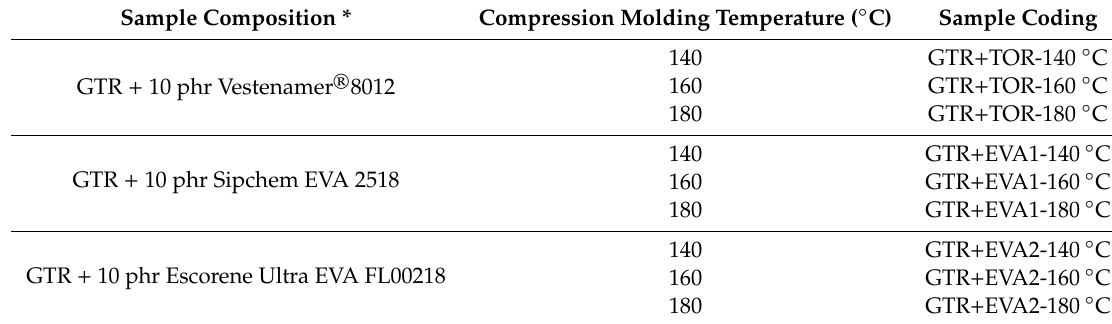
Table 2. Sample formulation and coding.